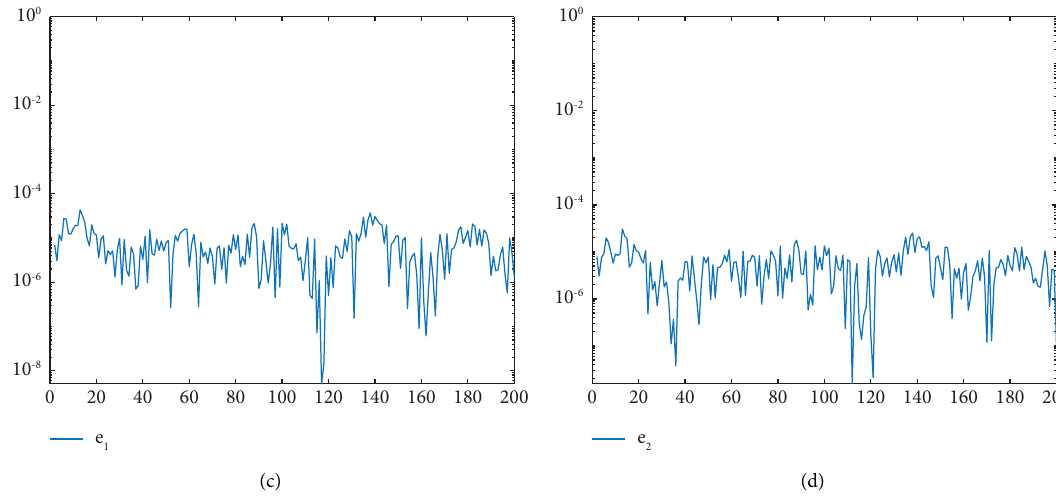
� 􏽢 φ : (a) synthesized robot trajectories, (b) end efector trajectory and k 2 k